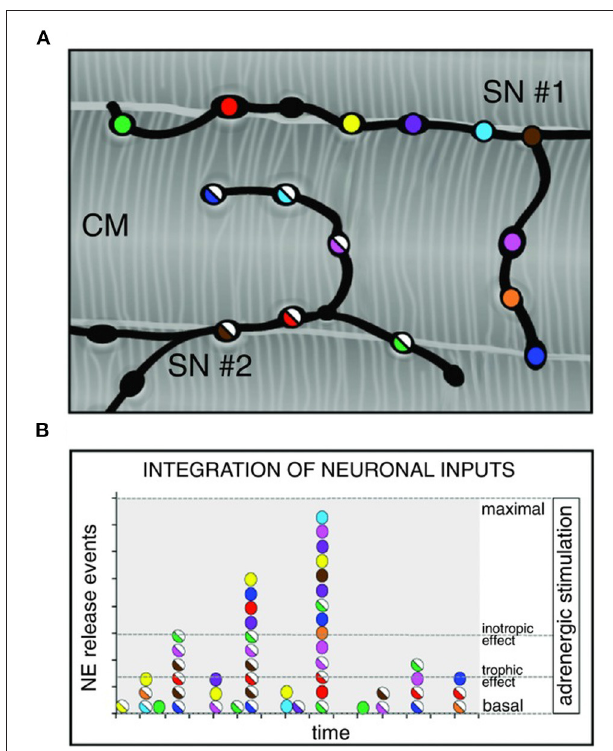
FIGURE 8 | Integration of multiple neuronal inputs by the innervated cardiomyocyte. (A) Recent advancements in imaging cardiac sympathetic innervation demonstrate that each CM interacts with multiple contacts from the same neuronal process (each varicosity is highlighted by one color) and may simultaneously be innervated by different neurons (two neurons in the picture are represented by filled or half-filled circles, respectively). (B) We thus made the hypothesis that activation of increasing number of varicosities, and recruitment of more neuronal processes, may allow grading of the responses of target cells from basal to maximal activation, across a wide range of intermediate effects. Modified with permission from Zaglia and Mongillo